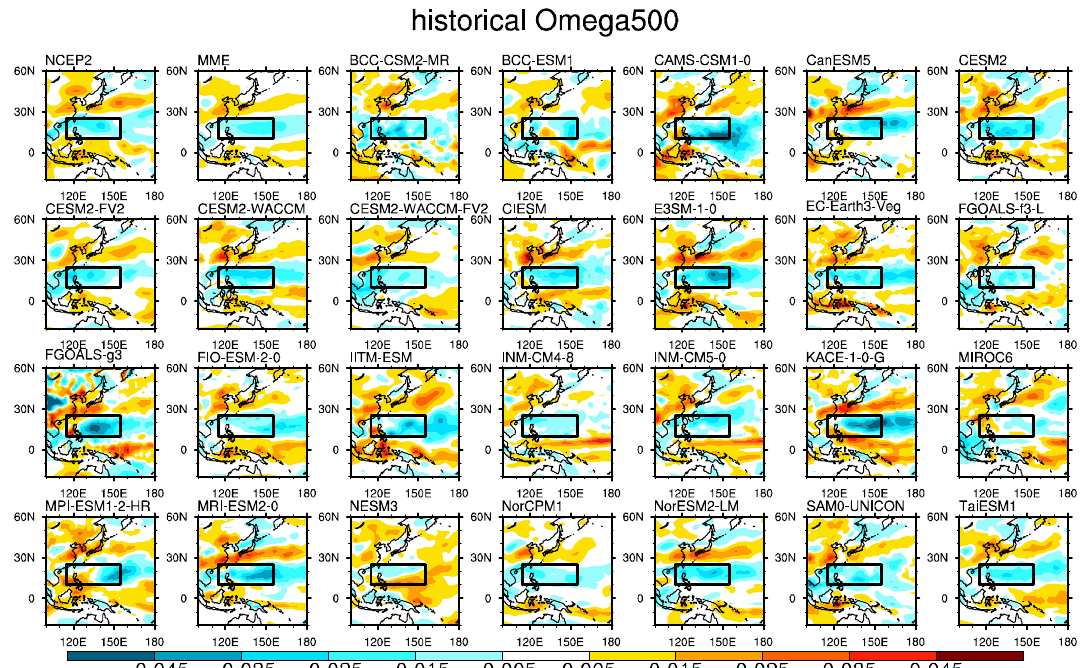
Figure 10. The same as Figure 8, but for the vertical velocity at 500-hPa (units: Pa/s).